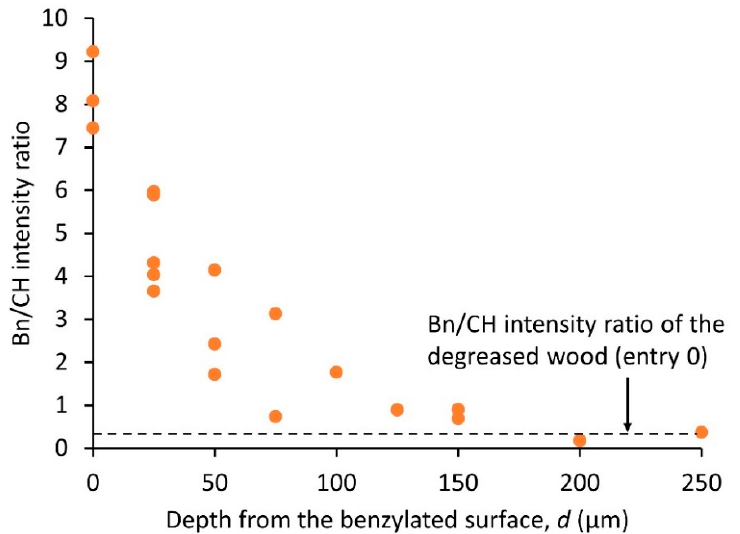
Figure 10. Relationship between the distance from the benzylated surface of entry 6 and the Bn/CH ratio at that point.